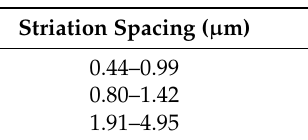
Figure 8. SEM images of ( a ) area 1, ( b ) area 2, and ( c ) area 3 showing striations perpendicular to crack propagation. The yellow boxes show striations and blue arrows denote the direction of crack propagation. Table 4. Striation spacing range.